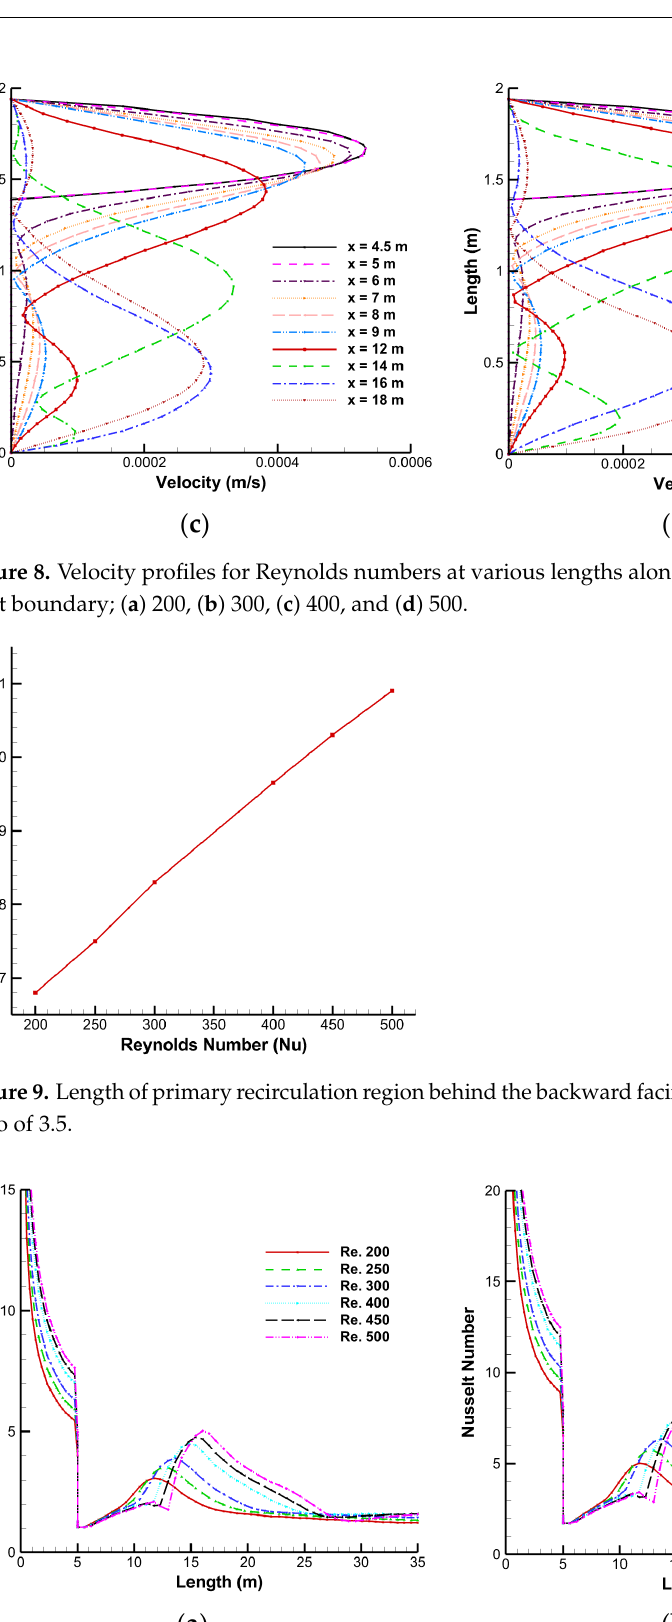
( d ) Figure 10. ( a ) Heat transfer coefficient, ( b ) Nusselt number, ( c ) skin friction coefficient, and ( d ) tem- perature. 5.3. Al 2 O 3 –H 2 O Nanofluid Flow over Backward Facing Step at ER—1.9432 Nanofluid flow over backward facing step at varying Reynolds number was per- formed.